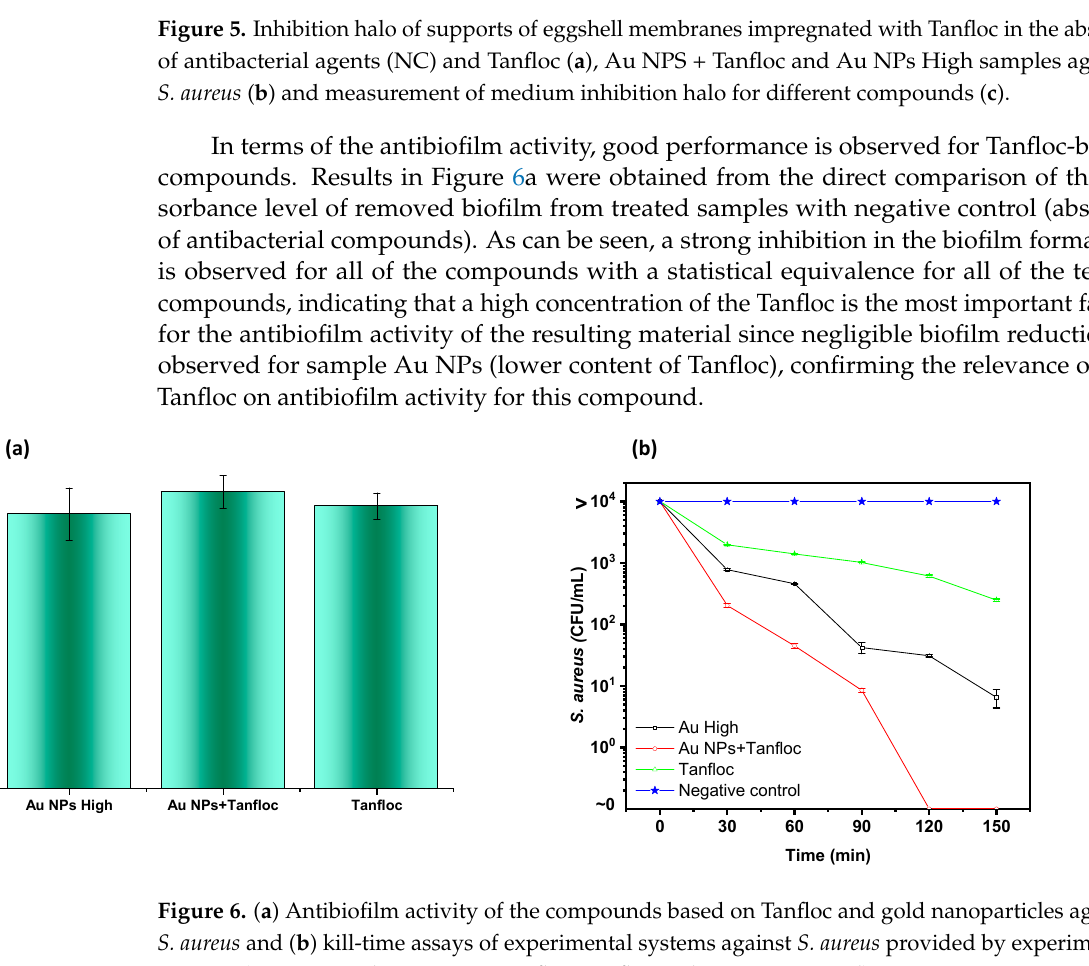
Figure 5. Inhibition halo of supports of eggshell membranes impregnated with Tanfloc in the absence of antibacterial agents (NC) and Tanfloc ( a ), Au NPS + Tanfloc and Au NPs High samples against S. aureus ( b ) and measurement of medium inhibition halo for different compounds ( c ).